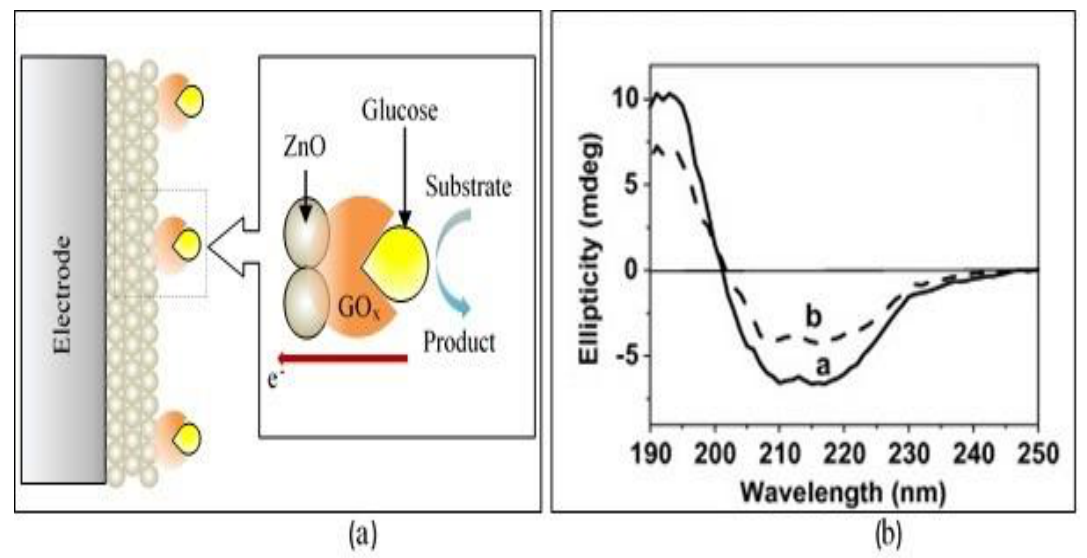
Figure 4. ( a ) Illustration of ZnO nanoparticles between electrode and glucose oxidase adsorbed on the nanoparticle surface. ( b ) Circular dichroism spectrum of glucose oxidase (curve a: GOx/ZnO bio-conjunction and curve b: pure GOx). Reprinted from [56]. Copyright 2009, with permission from